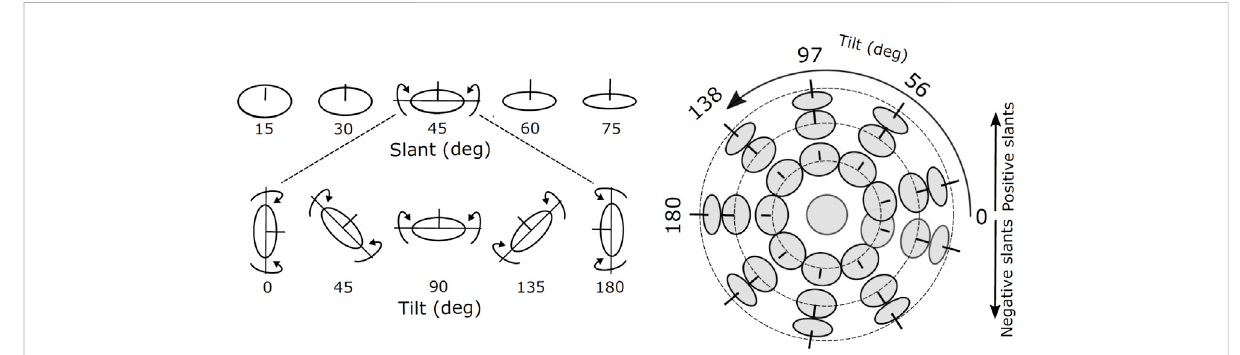
FIGURE 3 Images of oriented disks showing examples of slants and tilts components of surface orientation. The line segment at the center of each disk is aligned in the direction of the surface normal. The joint slant and tilt components form a spherical coordinate system in which lines of latitude have constant slant, and lines of longitude have constant